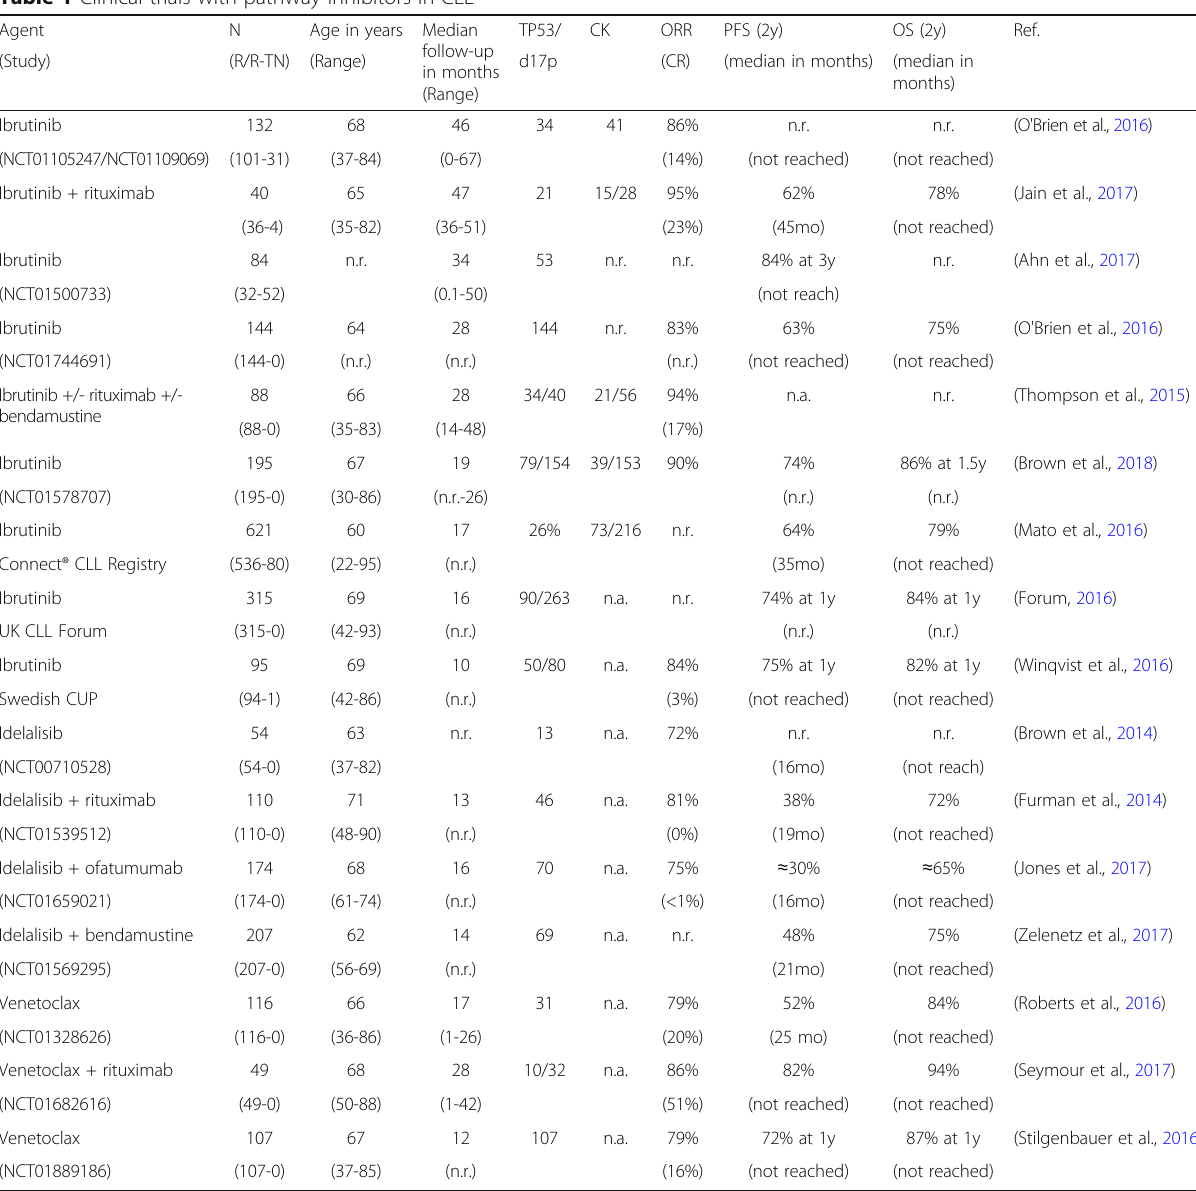
Table 1 Clinical trials with pathway inhibitors in CLL Agent N Age in years Median